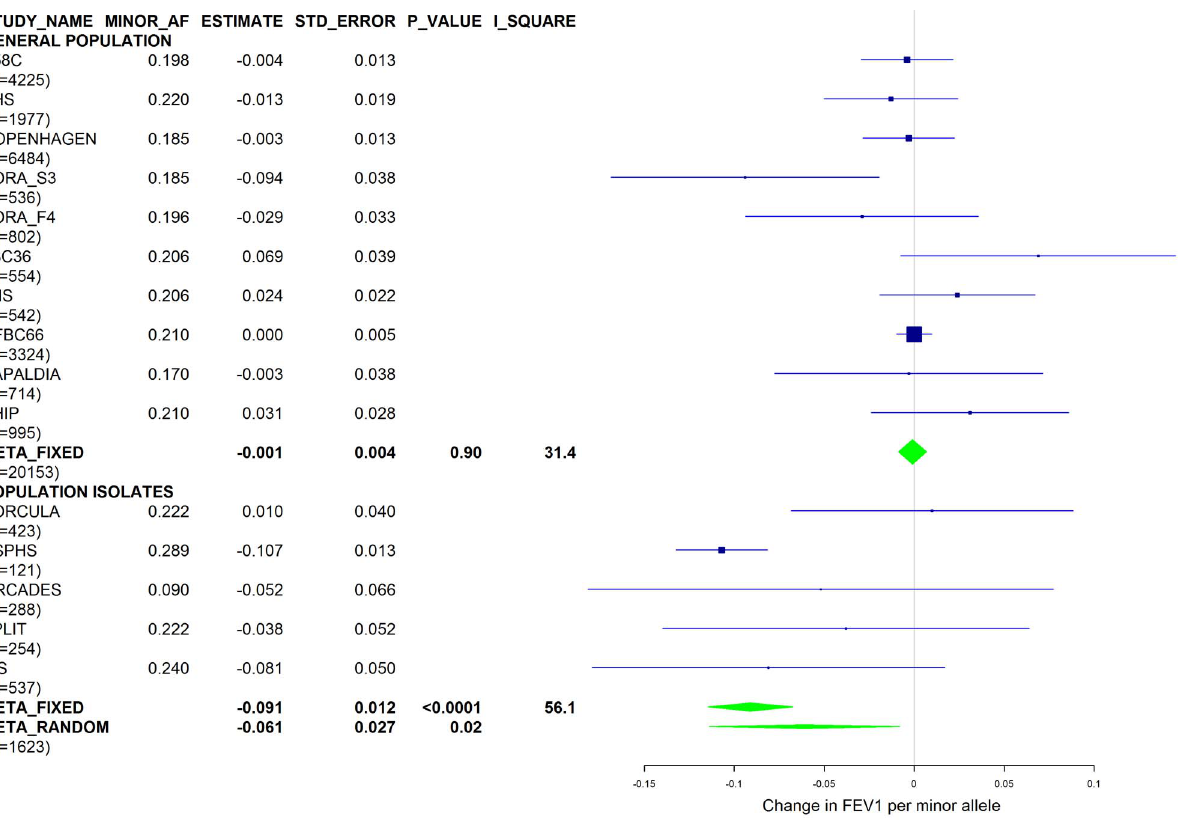
Figure 5. Forest plot of meta-analyzed results for the effect per minor allele of rs4905179 on FEV1 in ever-smokers, adjusted for sex, age, height and population stratification factors. Studies based on population isolates with a high degree of cryptic relatedness are presented separately. Effect estimates of meta-analyses are shown with green diamonds. I 2 is a measure of the heterogeneity between studies. Random effect meta-analyses are included if I 2 . 0.5. Study weights (blue squares) correspond to fixed effect meta-analyses.